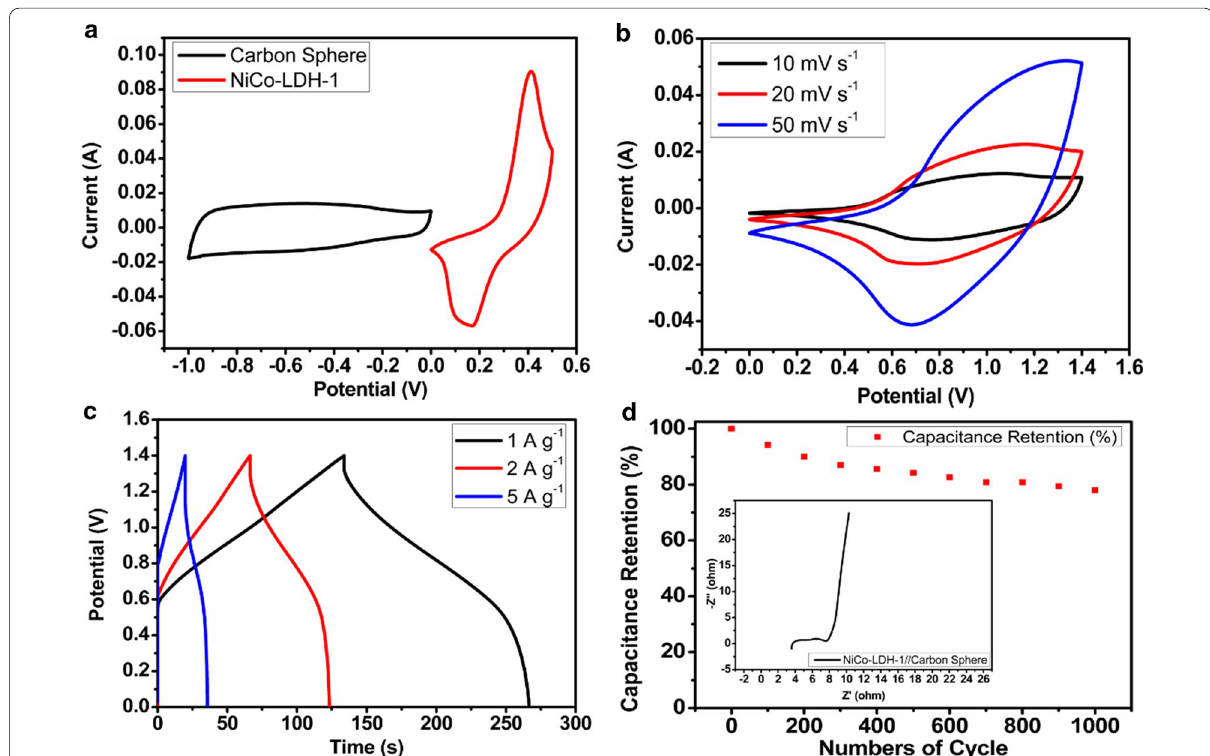
Fig. 6 Electrochemical performance of the NiCo-LDH-1/carbon sphere asymmetric supercapacitor: a CV curves at scan rate of 10 mV s − 1 ; b CV curves under different scan rates; c GCD curves at different current densities; and d cyclic stability under the current density of 10 A g −